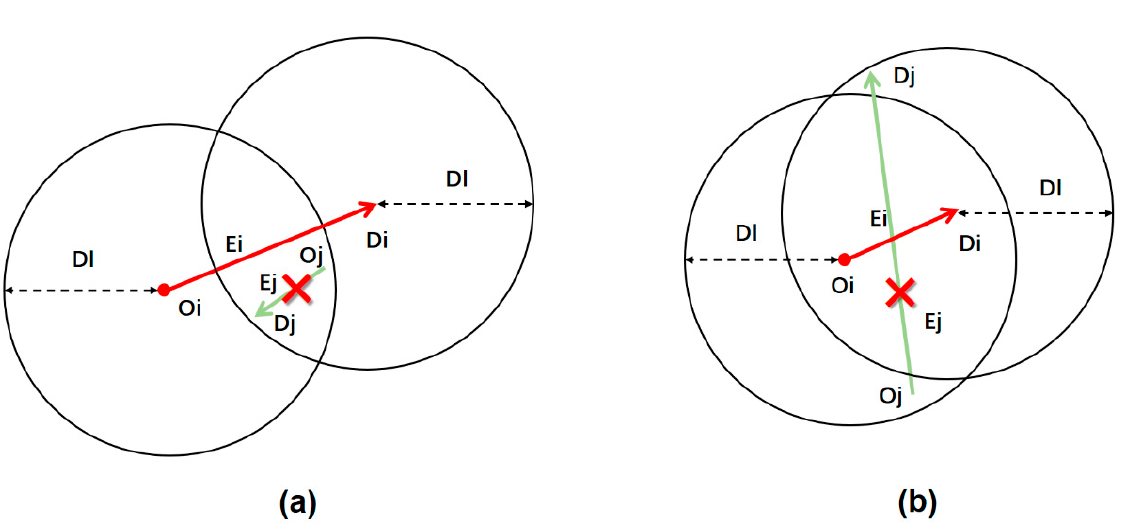
Figure 5. Using distance constraint alone cannot guarantee spatial similarity ( a ) Approximate op- posite direction ( b ) Approximate orthogonal direction. opposite direction ( b ) Approximate orthogonal